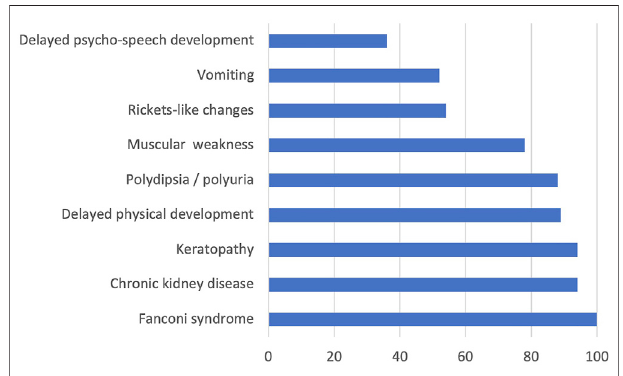
FIGURE 1 | Calibration characteristics of the analytics system. The square of the calibration characteristic correlation quotient was 0.997. The lowerthresholdofquantitativecystinedetectionwas0.11 μ mol/L.Thecystine detection threshold was 0.01 μ mol/L ( Figure 2 ). The time of analysis for one probe was 15 min. The obtained data were processed using a built-in Bruker Data Analysis 4.1 program package.